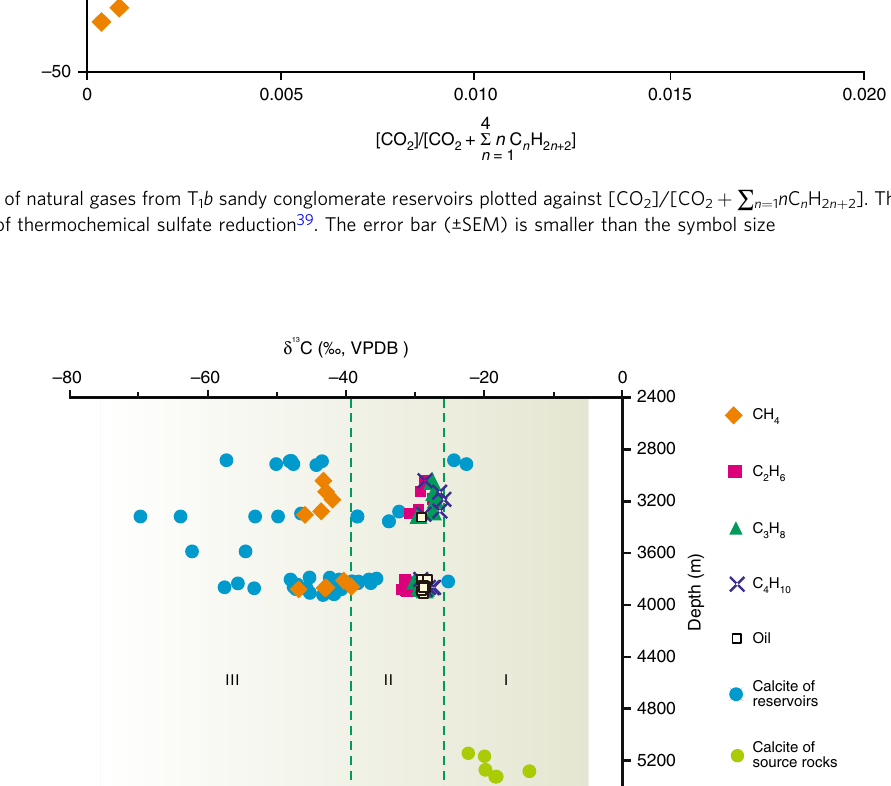
Fig. 7 Carbon isotopes of natural gas, calcites from reservoir strata, and calcite veins from source rocks. Region I represents carbonates associated with decarboxylation of organic acids, while Region III denotes carbonates derived from the oxidation of methane. Region II indicates carbonates associated with a combination of the oxidation of methane and small quantities of C 2 + , as well as decarboxylation. The error bar (±SEM) is smaller than the symbol size